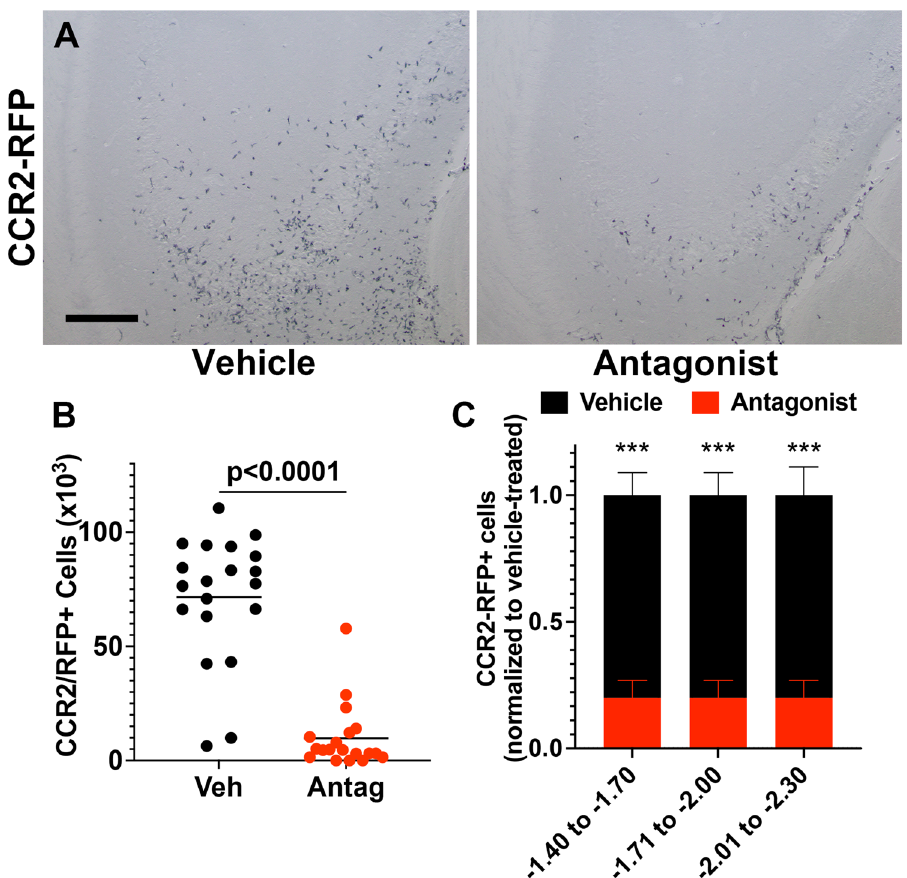
Figure 3. CCR2 antagonist blocks monocyte entry into the hippocampus after SE. ( A ) Ccr2 + /rfp mice (n = 20) subject to KA and vehicle showed hippocampal infiltration of CCR2-RFP + monocytes three days after SE, whereas KA Ccr2 + /rfp mice (n = 18, one statistical outlier removed) subject to the CCR2 antagonist displayed greatly reduced numbers of CCR2-RFP + monocytes in the hippocampus. Scale bar is 200 μm. ( B ) Stereological analysis revealed ~ 71,700 monocytes in vehicle-treated KA mice three days after SE and ~ 9,790 monocytes in CCR2 antagonist-treated KA mice (unpaired t-test, p < 0.0001). The horizontal line is at the mean, and each symbol represents data from one mouse. The outlier, if retained, would not have changed the interpretation. ( C ) Plot of the number of CCR2-RFP+ monocytes tabulated and normalized to vehicle-treated controls in the hippocampus segmented across Bregma coordinates listed on the x-axis. One-way ANOVA followed by Holm-Sidak’s comparisons tests found significant differences between treatments in all three regions examined (*** p < 0.0001 for each region). Bars indicate mean ±